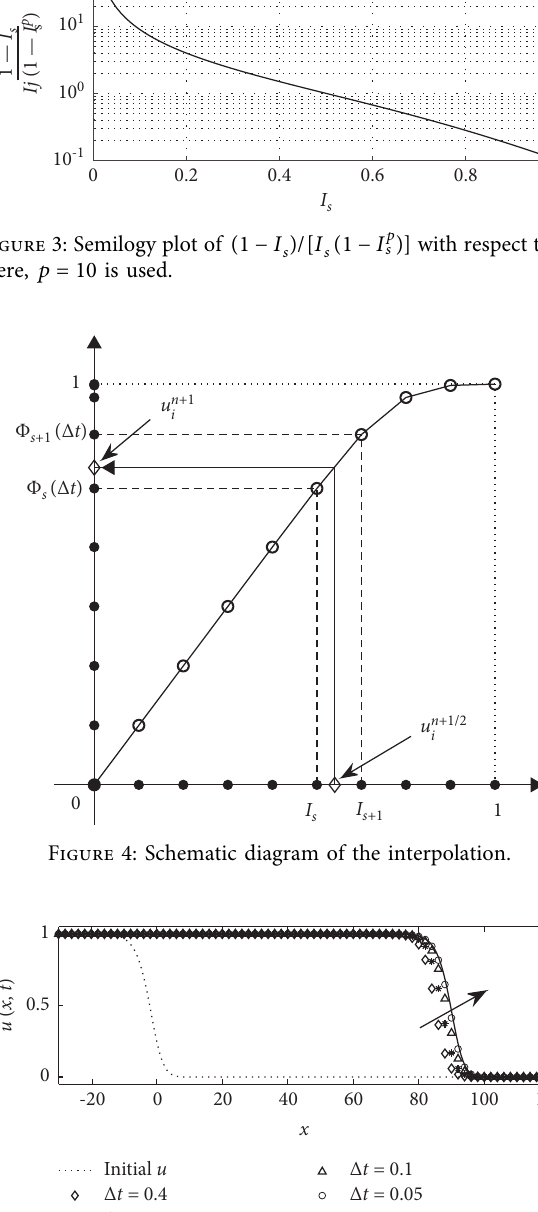
Figure 5: Convergence of the numerical solutions with respect to Δ t values at t �